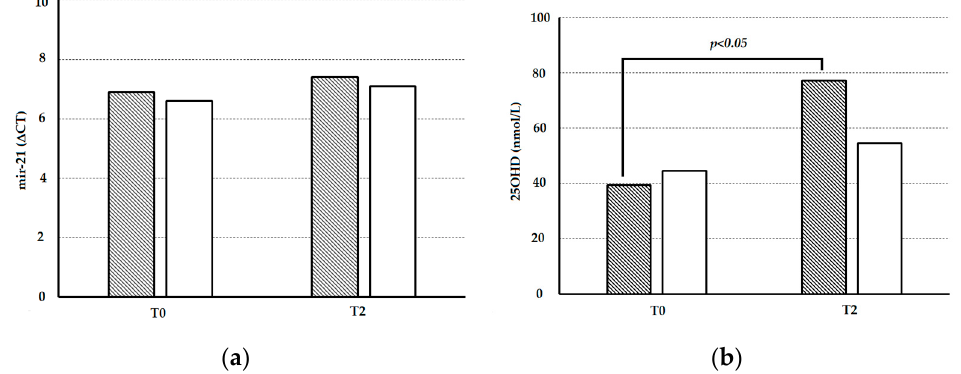
Figure 1. Circulating levels of miR-21 and 25OHD in the study cohorts before and after treatment with cholecalciferol or placebo: ( a ) miR-21 circulating levels in C-cohort HYPODD patients (dark histograms) and in P-cohort HYPODD patients (white histograms) before (T0) and two months (T2) after treatment with cholecalciferol (C-cohort) or with placebo (P-cohort); ( b ) 25OHD serum levels in C-cohort HYPODD patients (dark histograms) and in P-cohort HYPODD patients (white histograms) before (T0) and two months (T2) after treatment with cholecalciferol (C-cohort) or with placebo (P-cohort).